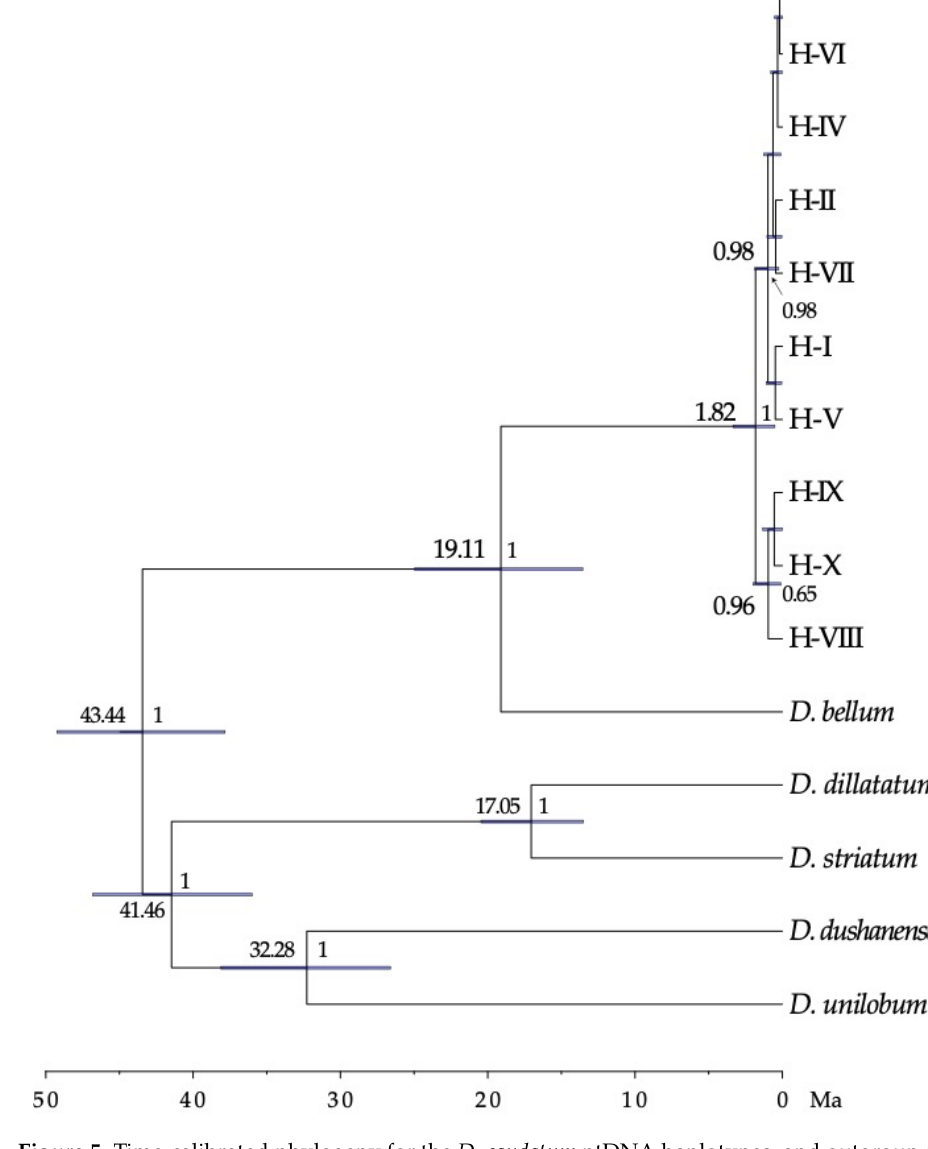
Figure 5. Time-calibrated phylogeny for the D. caudatum ptDNA haplotypes, and outgroup species, derived from BEAST. Numbers above branches are the mean divergence ages (in million years ago) for each node; blue bars represent 95% highest posterior density intervals for each node; numbers after nodes are BEAST posterior probabilities; the time scale is printed in million years ago (Ma). Only data for nodes with pp > 0.6 are shown.